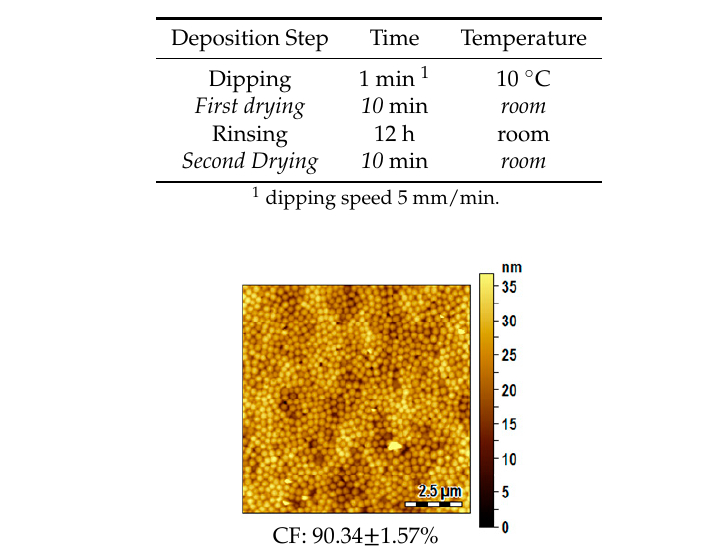
Figure 5. AFM image of the MGs film realized onto the gold coated fiber tip with a dipping time and drying steps reduced respectively to 1 min and 10 min, and rinsing time of 12 h.